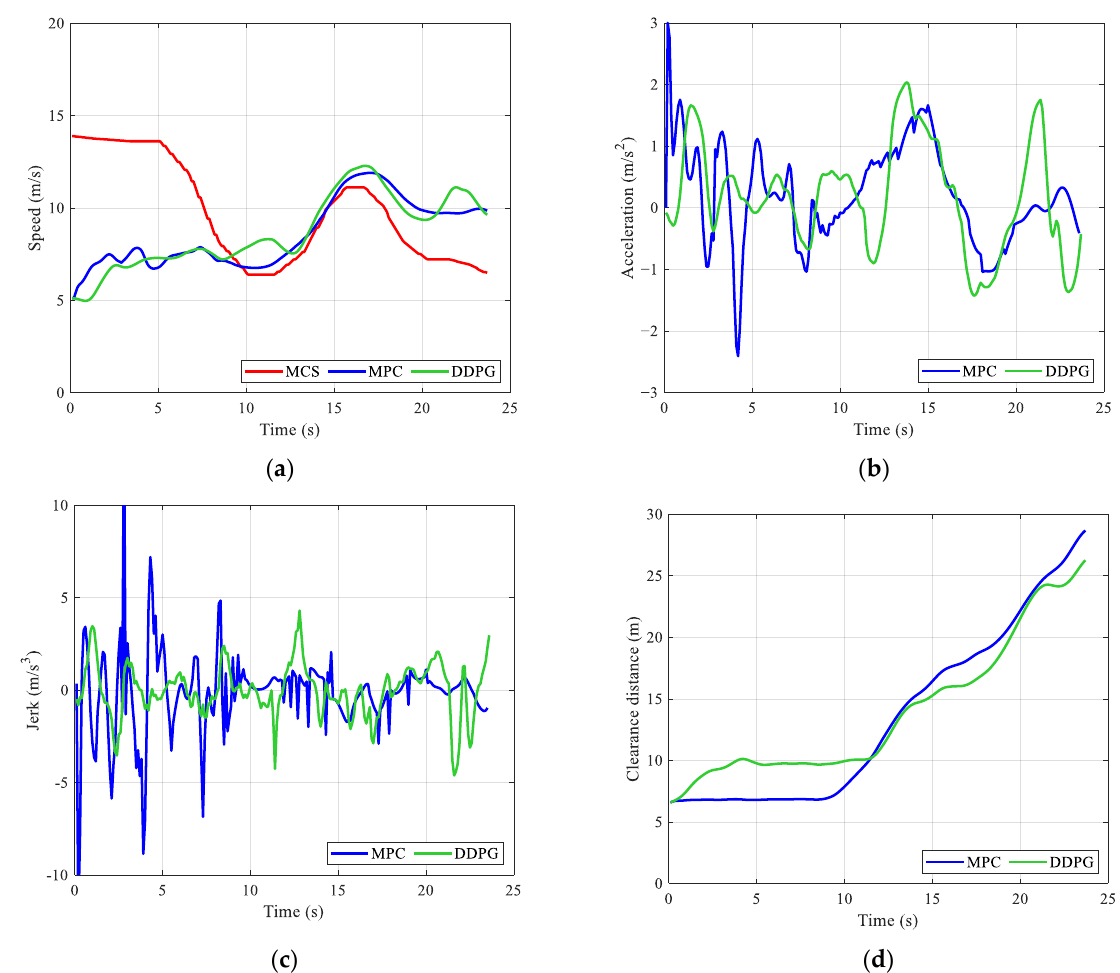
Figure 10. Speed control results for the AV with the leading vehicle No. 326 and a starting point at location 500 m on the sampled rough pavement: ( a ) speed, ( b ) acceleration, ( c ) jerk, and ( d ) clearance distance.